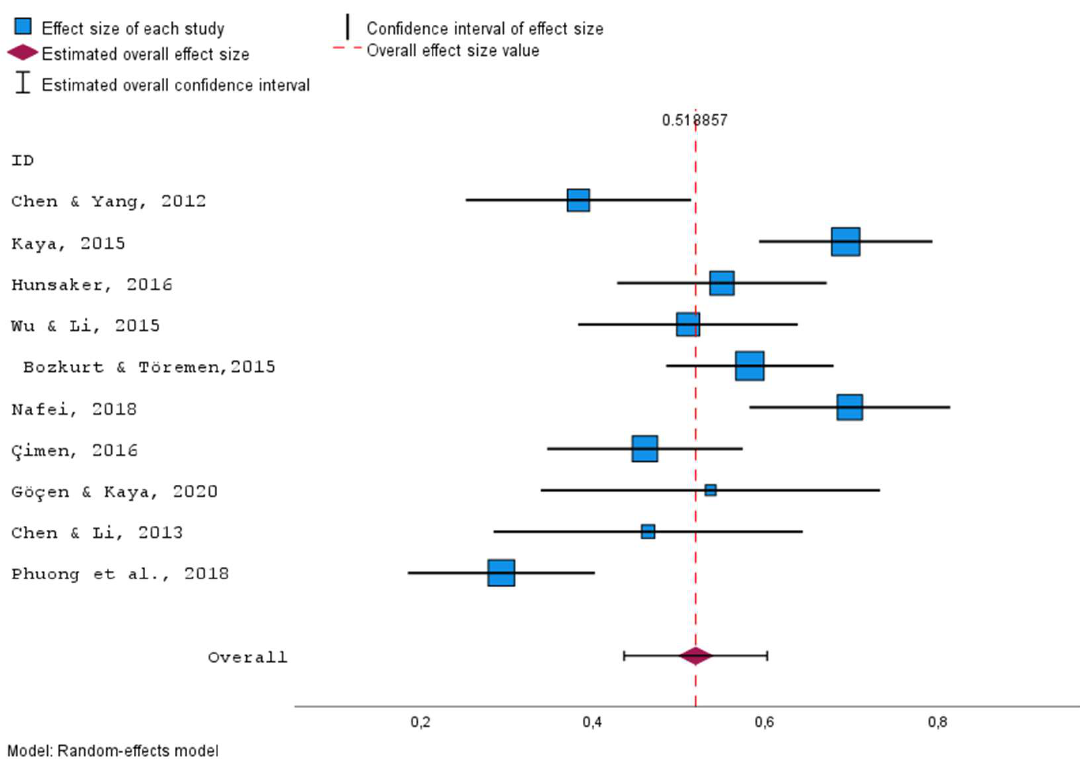
Figure 15. Forest Plot for Correlation Data.